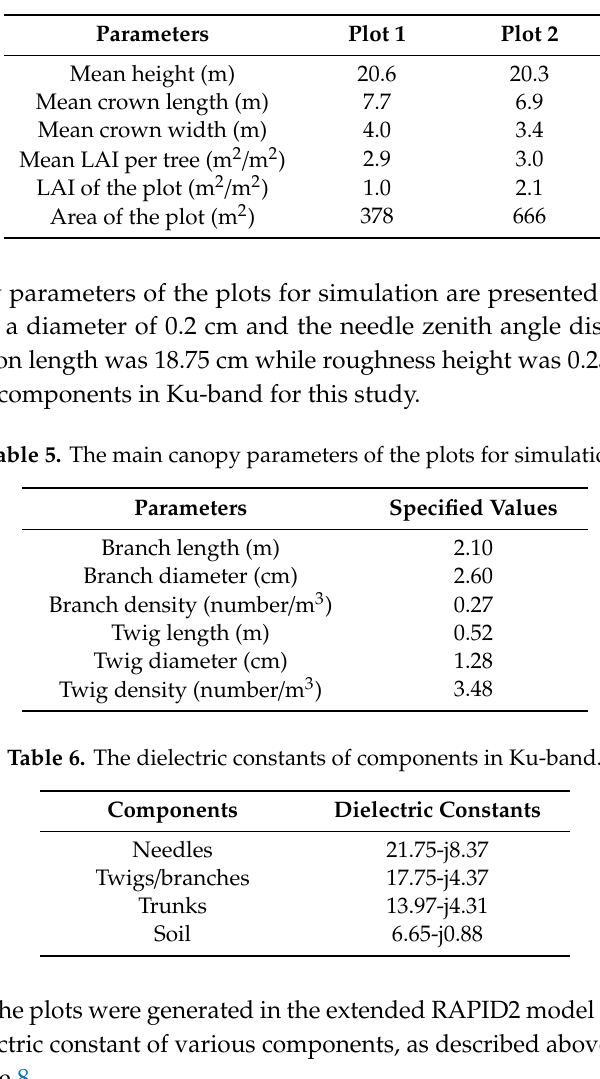
Table 4. The major structure parameters of the two plots extracted from lidar.